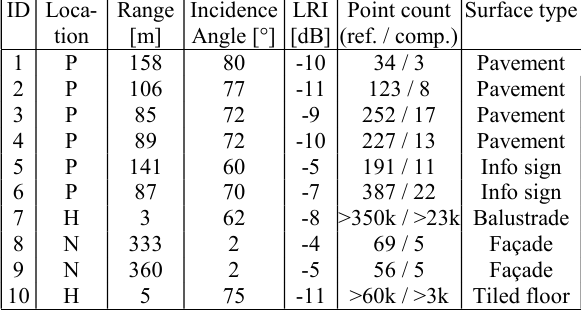
Table 1. Location and properties of control planes in the paved area (P), on the neighboring building (N), and on the hotel roof (H). Given properties are the measurement range to the TLS sensor, incidence angle, laser return intensity (LRI) and number of points representing the plane in the reference (high- resolution) and an exemplary compare point cloud The properties of the control plane locations are listed in Tab.